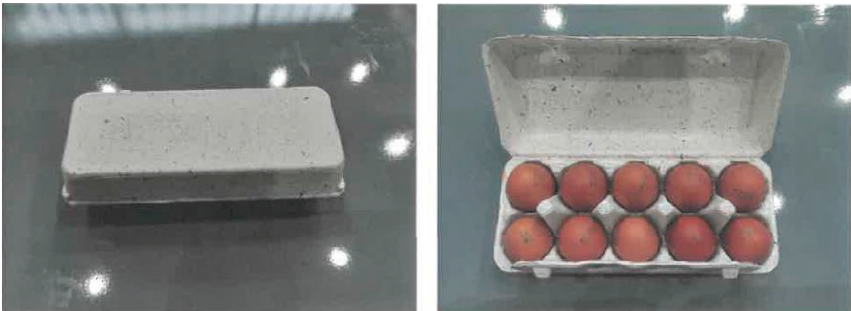
Figure 11: An image of the fabricated egg carton, based on the biodegradable film considered in this